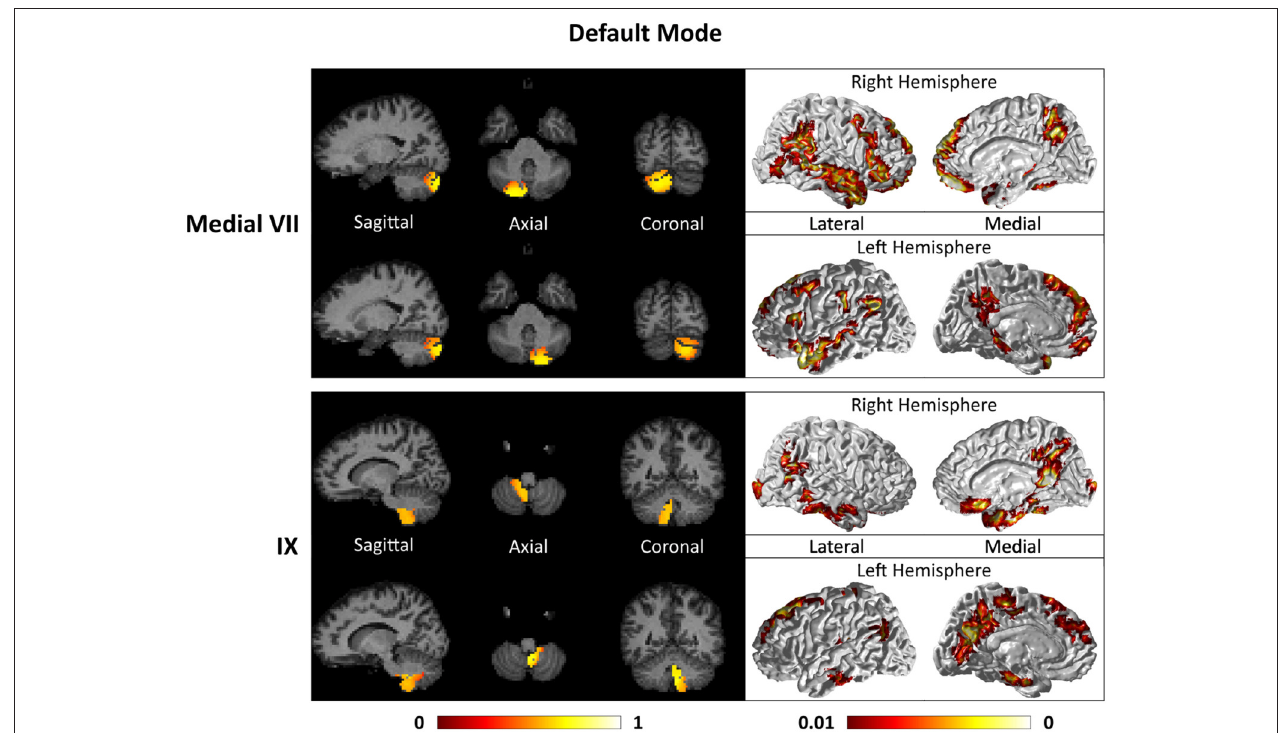
FIGURE 8 | Cerebellar clusters (left column) that correspond to lobules medial VII (first row) and IX (second row) are found to be functionally connected to cortical regions lying in the default mode network (right column).